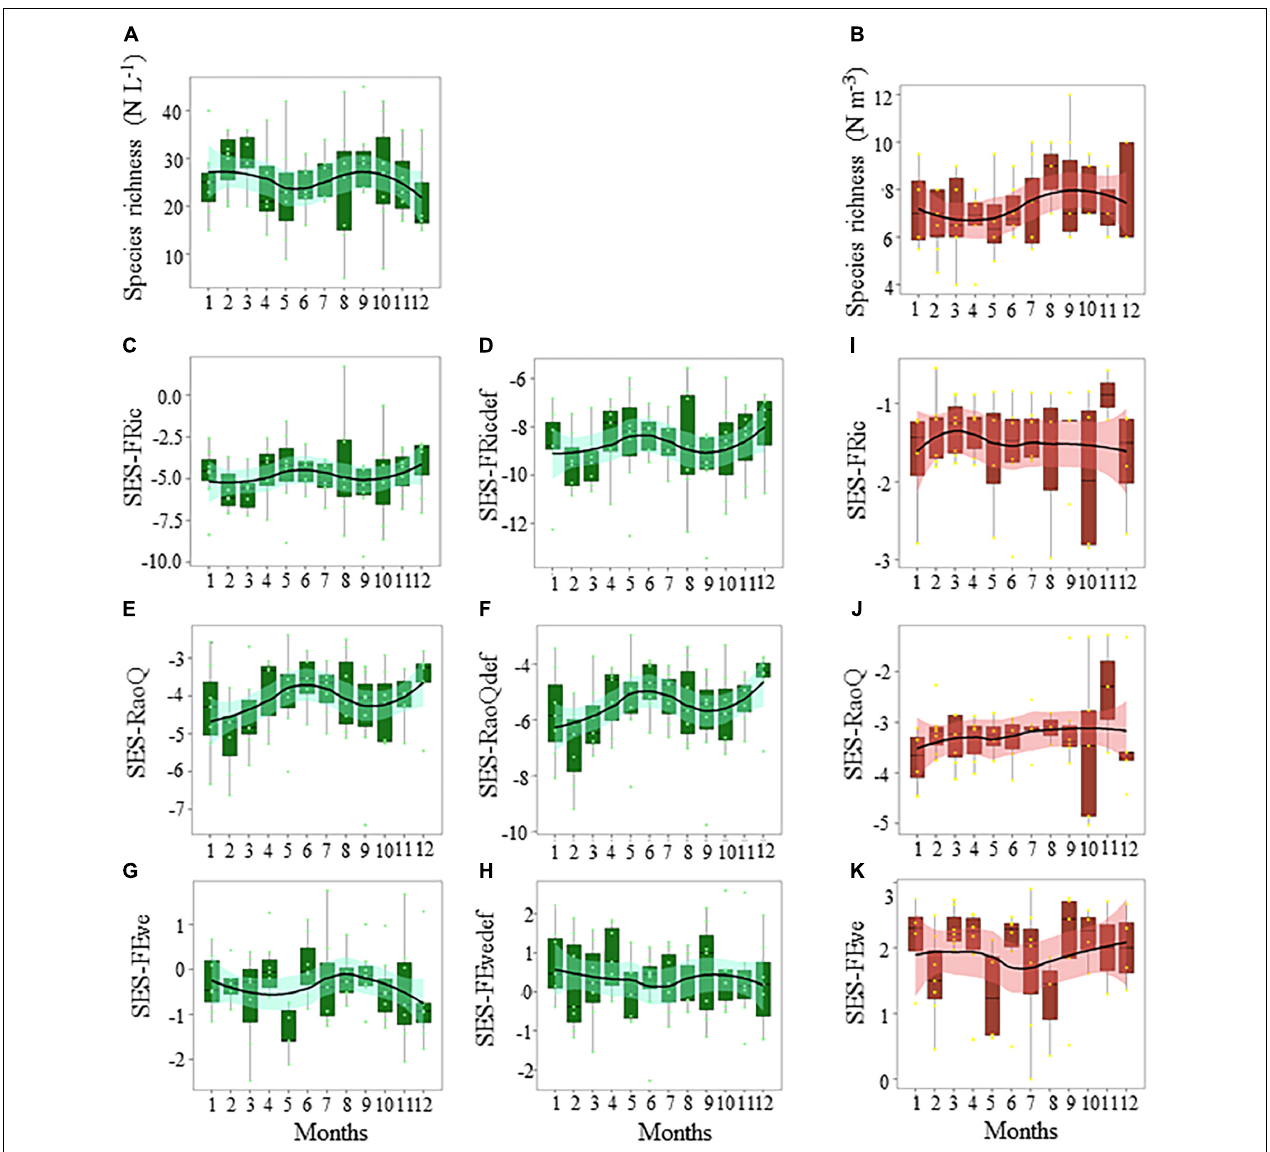
FIGURE 5 | Seasonal variations in the panels (A,B) species richness, (C–E) functional richness (SES-Fric), (E,F,J) functional divergence (SES-RaoQ), and (G,H,K) functional evenness (SES-Feve) of the diatom ( A–H , in green) and copepod ( B,I–K , in red) community in coastal waters of the eastern English Channel over the period 2007–2013. Def: defence traits against predation. Black horizontal line inside box: median; box: first to third quartiles; whiskers: 1.5 times the interquartile range (IQR); dots: monthly data including outliers ( > 1.5 times IQR). The solid line and ribbon represent LOESS smoothing and the 95% confidence interval. No difference between months ( p > 0.05, Nemenyi test) was found between boxes for any of the